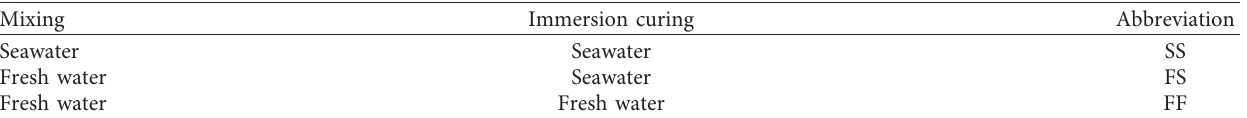
Table 6: Shaping and curing scheme.